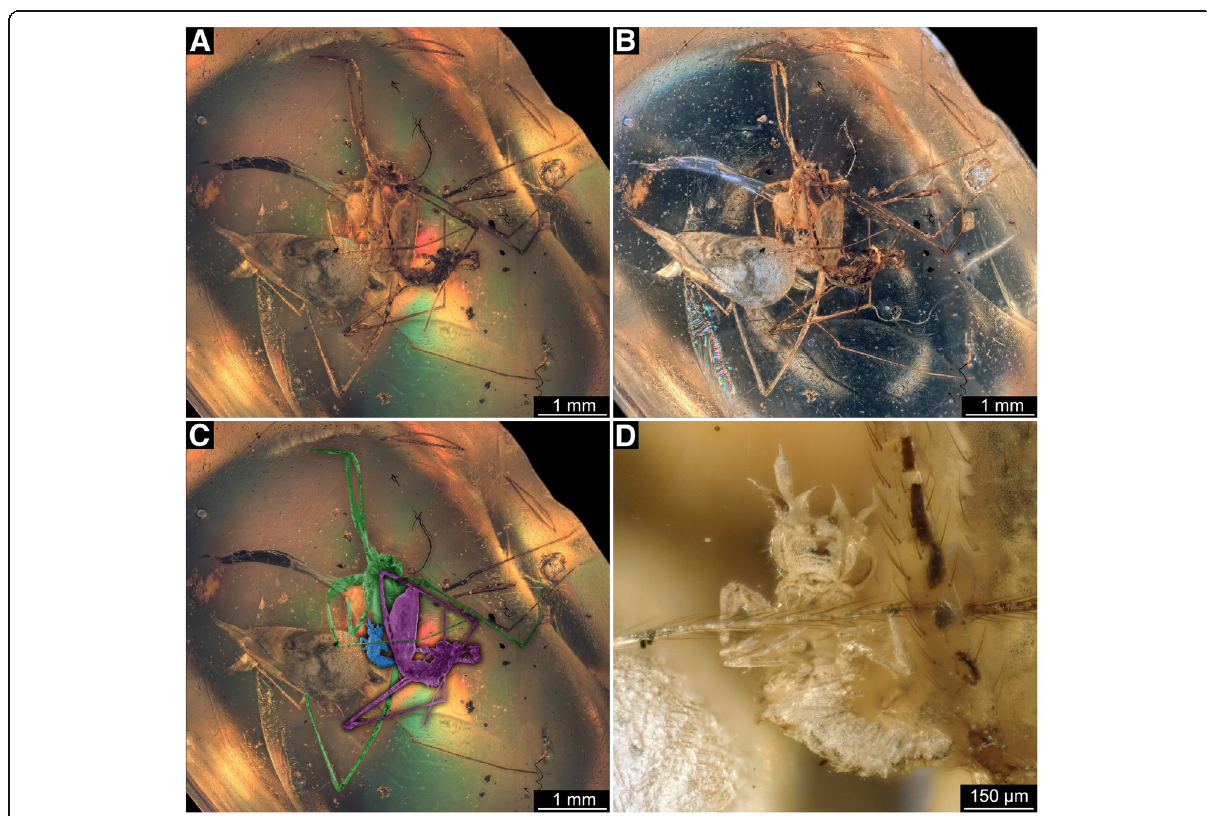
Fig. 1 Overview of the amber piece with the mantis lacewing larva. a – c . Overview images. a Under coaxial cross-polarised light. b Under low- angle reflective ring illumination. c Colour-marked version of A; male spider ( Priscaleclercera ) in purple; female spider ( Burmorchestina ) in green; neuropteran larva in blue. d Close-up on larva; coaxial cross-polarised light, single exposure